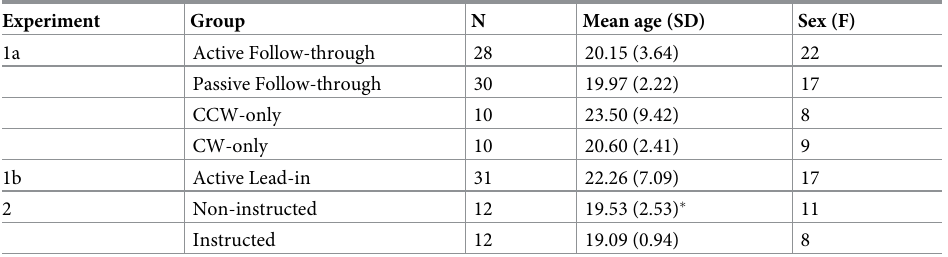
Table 1. Demographic summary of experimental groups including sample size, mean and standard deviation of age, and sex (number of female participants).